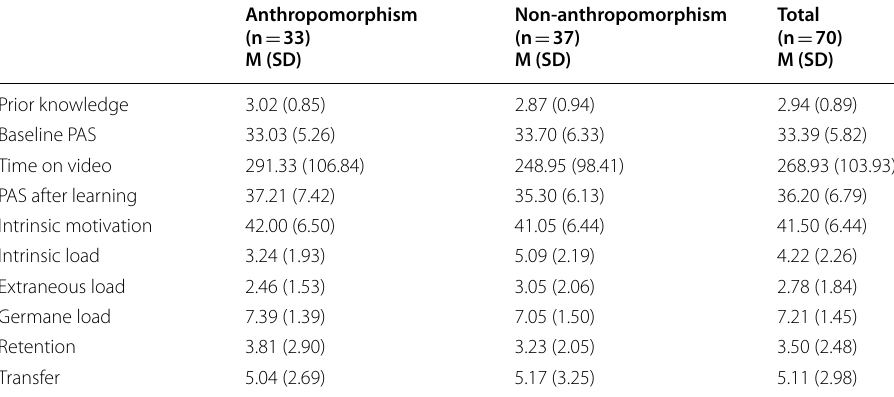
Table 4 Means and standard deviations of the